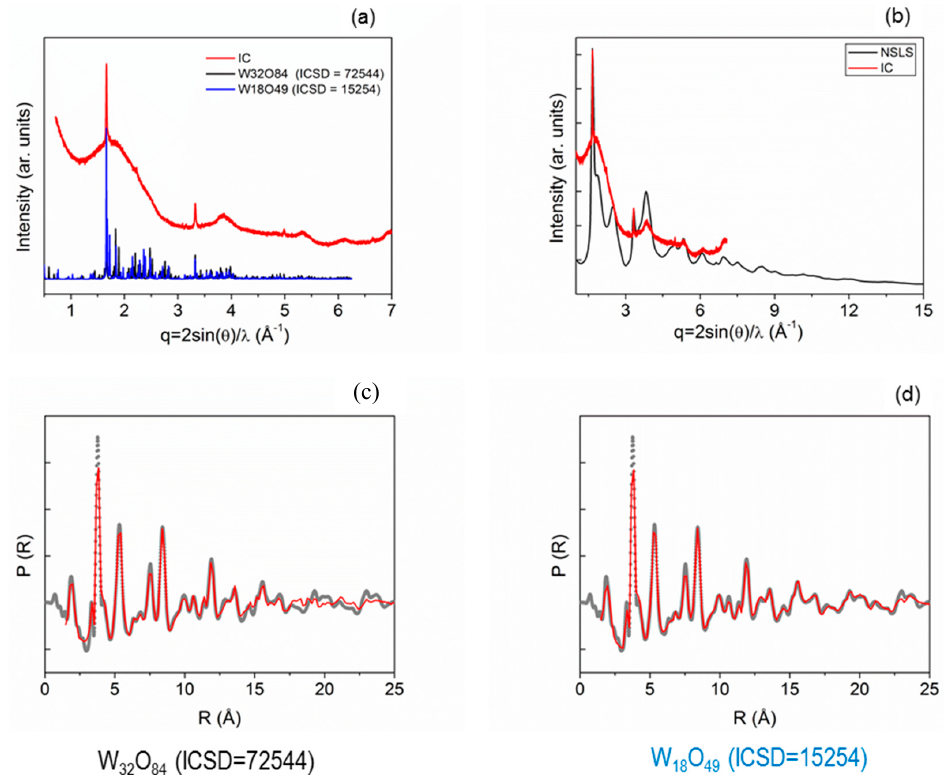
Figure 8. ( a ) X-ray diffraction (XRD) pattern of a WOx rod-like material, indexed with two different Magnéli phases: the orthorhombic W 32 O 84 (ICSD #72544) and the monoclinic W 18 O 49 (ICSD #15254); ( b ) diffraction data collected in transmission scanning mode with λ = 0.18597 Å at the X17A beamline of the National Synchrotron Light Source (NSLS; NSLS-XPD) at Brookhaven National Laboratory (black line) compared to laboratory data (red line) collected with a Bruker D8-Discover diffractometer, in reflection mode, with Cu K α 1 radiation, i.e., λ = 1.540562 Å; ( c ) experimental PDF (dotted grey curve), derived from the NSLS diffraction profile in ( b ), and theoretical PDF (red lines) computed from the W 32 O 84 (ICSD #72544); ( d ) experimental PDF (dotted grey curve) and theoretical PDF (red lines) computed from the W 18 O 49 (ICSD #15254). Partially reprinted with permission from reference